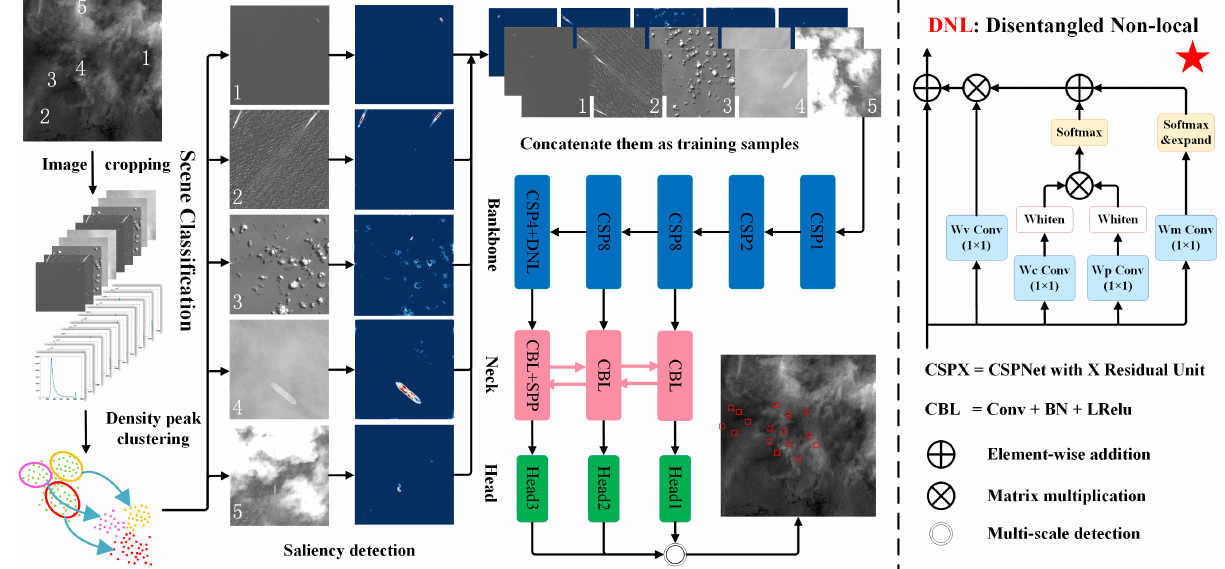
Figure 2. The overall flowchart of proposed saliency tuned YOLONet for ship detection. First, we utilized the grayscale histograms of each block to classify scenes. Second, the saliency maps were regarded as third channels. Finally, they were separately fed into the YOLO network adjusted by the DNL